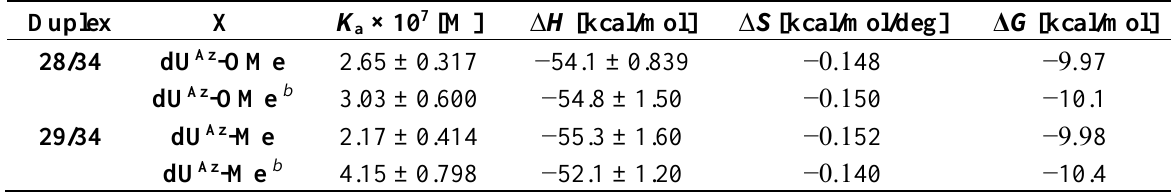
Table 7. Thermodynamic parameters of duplexes formed by dU Az analogue-modified ONs with complementary RNA a . Duplex X K × 10 7 [M] ∆ H [kcal/mol] ∆ S [kcal/mol/deg] Δ G a